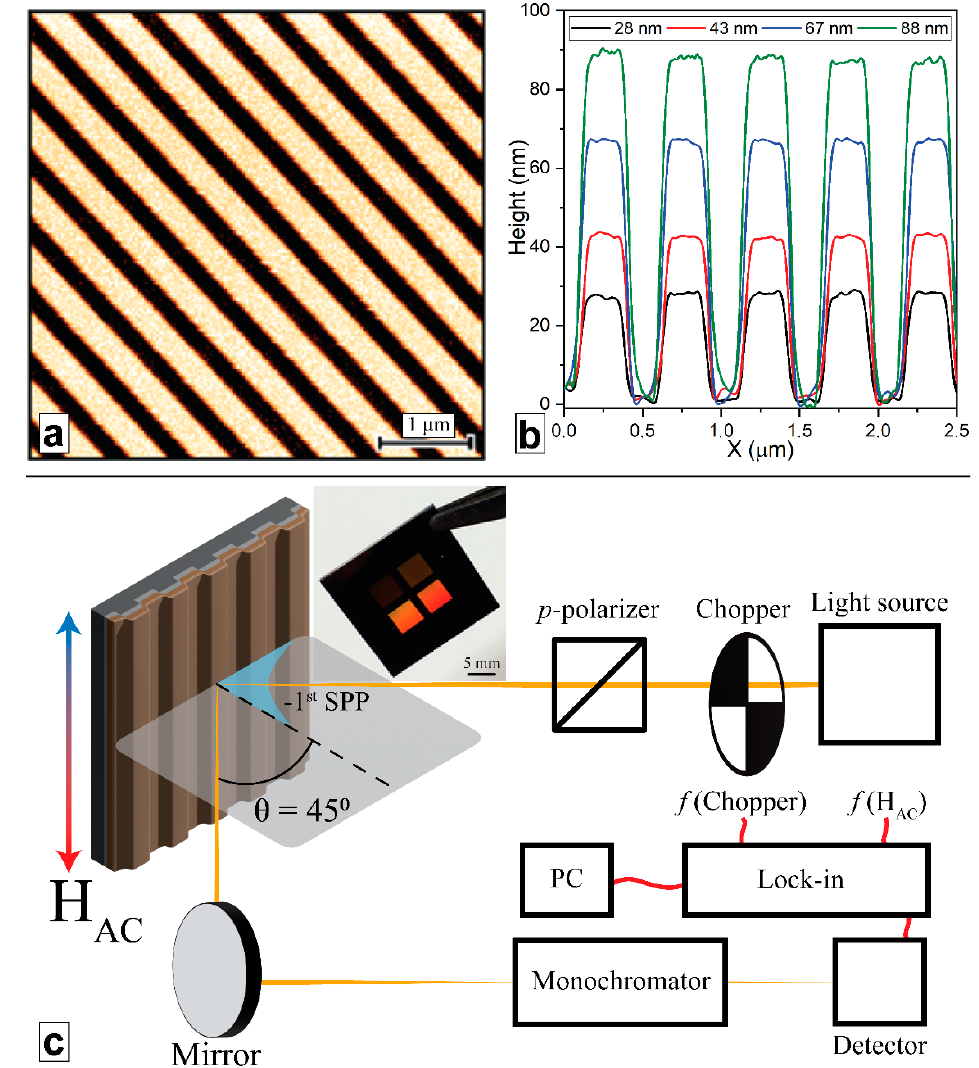
Figure 1. ( a ) AFM image of the diffraction grating with a stripe’s height of 88 nm. ( b ) Profiles of the fabricated diffraction gratings with stripes’ heights of 28 (black), 43 (red), 67 (blue), and 88 (green) nm. ( c ) Scheme of the setup used to measure reflectivity and TKE values of studied MPlCs. The angle of light incidence θ = 45°. H AC is the external modulation AC magnetic field applied to an MPlC along the diffraction grating stripes, and f (Chopper) and f ( H AC ) are modulation chopper and magnetic field reference frequencies, respectively, used for the detection of optical and magneto-optical signals. The inset shows a photo of the fabricated sample containing four MPlCs.